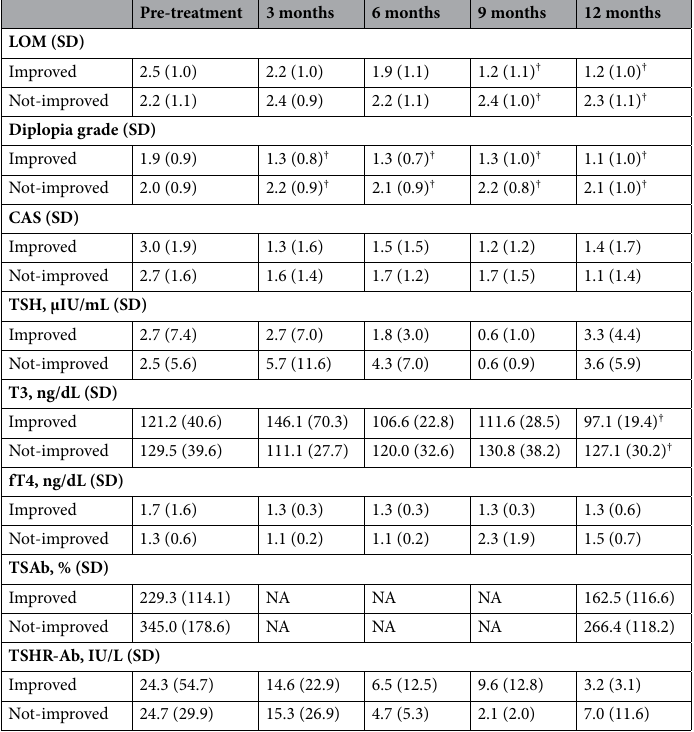
Table 3. Comparisons of longitudinal changes in the limitation of extraocular movement, diplopia, clinical activity score, and thyroid status in the improved and not-improved groups. LOM limitation of muscle excursion, CAS clinical activity score, TSH thyroid stimulating hormone, T3 triiodothyronine, fT4 free thyroxine, TSAb thyroid-stimulating antibody, TSHR-Ab thyroid stimulating hormone receptor antibody. † The difference between the two groups was significant ( P < 0.05, Student’s t test or Mann Whitney U